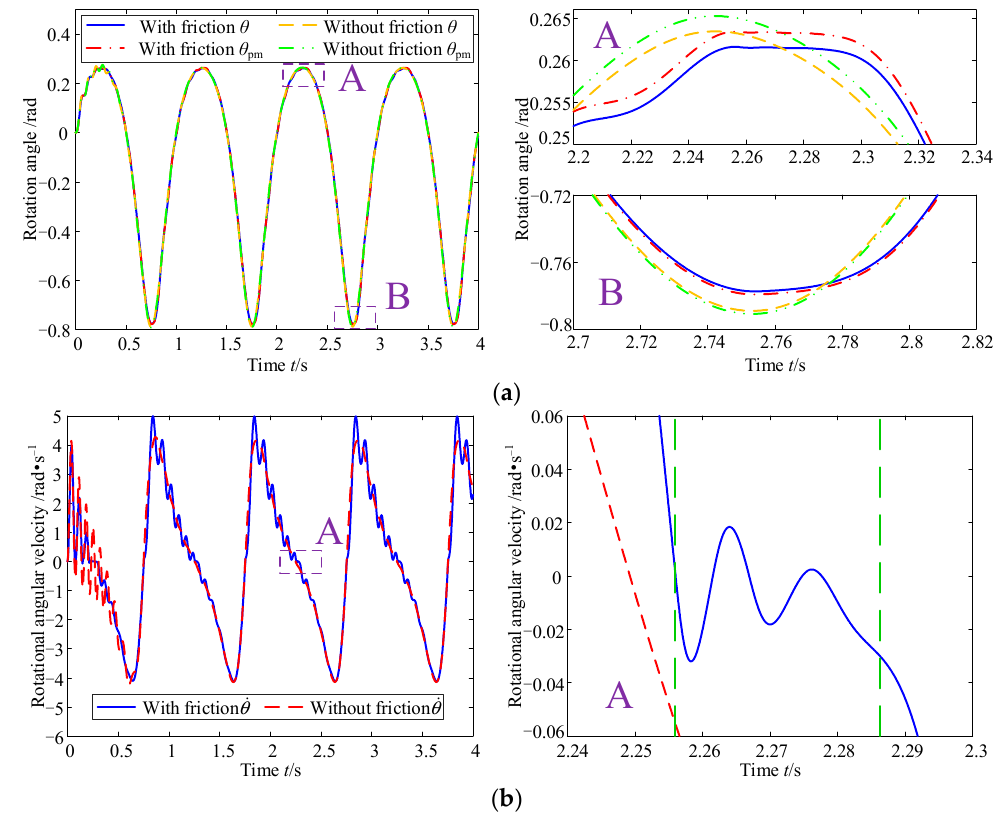
Figure 4. Effect of friction on the dynamic performance of position motor systems at variable stiffness: ( a ) rotation angle and ( b ) rotational angular velocity.